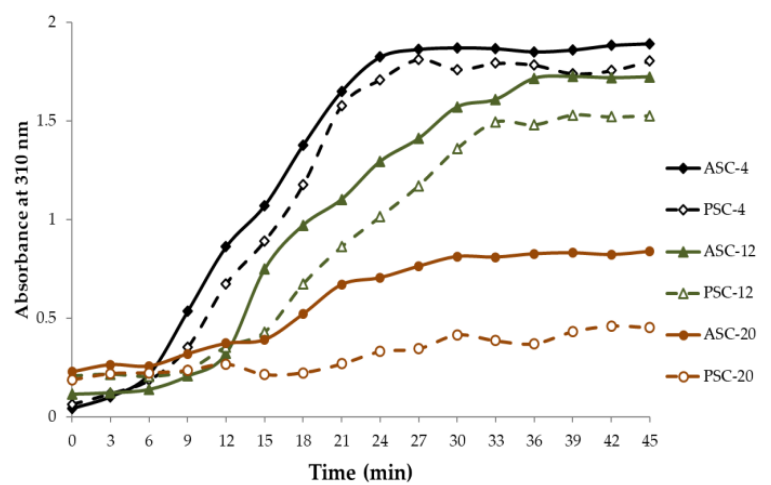
Figure 4. Turbidity – time curves of resulting fibrils of ASC and PSC extracted at 4, 12, and 20 °C from the skin of pufferfish. ASC: acid-solubilized collagen; PSC: pepsin-solubilized collagen.